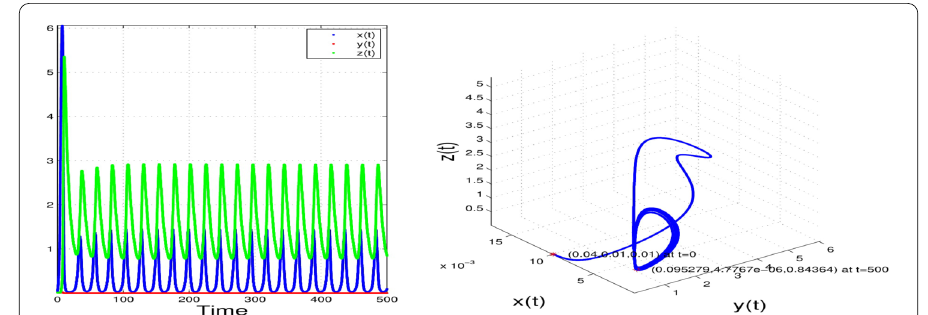
Figure 7 The local stability of the equilibrium FPFE